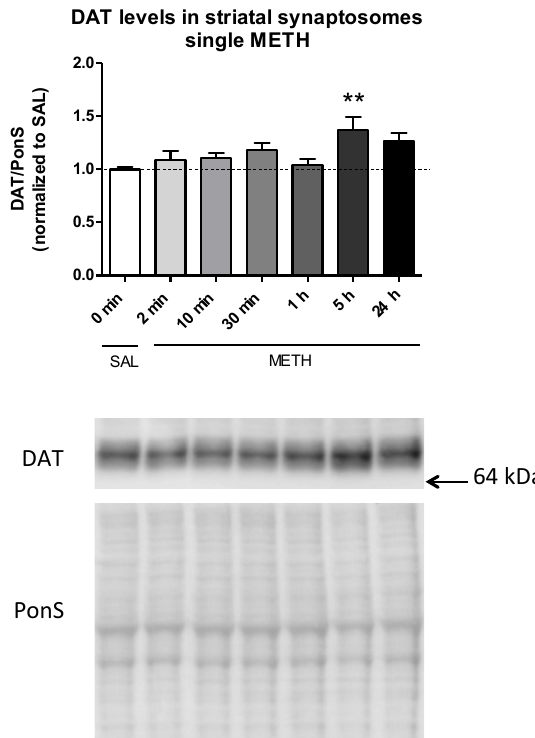
Figure 4. The effect of single intravenous (i.v.) dose of METH on the immunoreactivity of dopamine transporter (DAT) in rat striatal synaptosomes (total fraction). The time course of DAT immunoreactivity after 6 mg/kg METH shows an increase (+37%, ** p < 0.01) in DAT immunoreactivity at 5 h after METH injection. Abbreviations: METH, methamphetamine; PonS, Ponceau S; SAL,